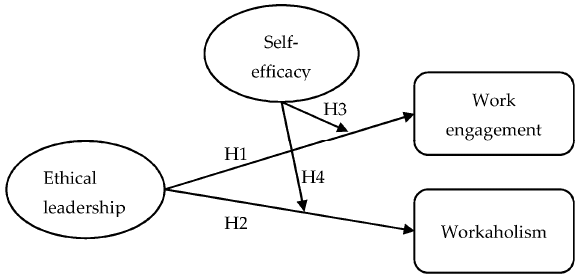
Figure 1. Research framework. Source: the authors .